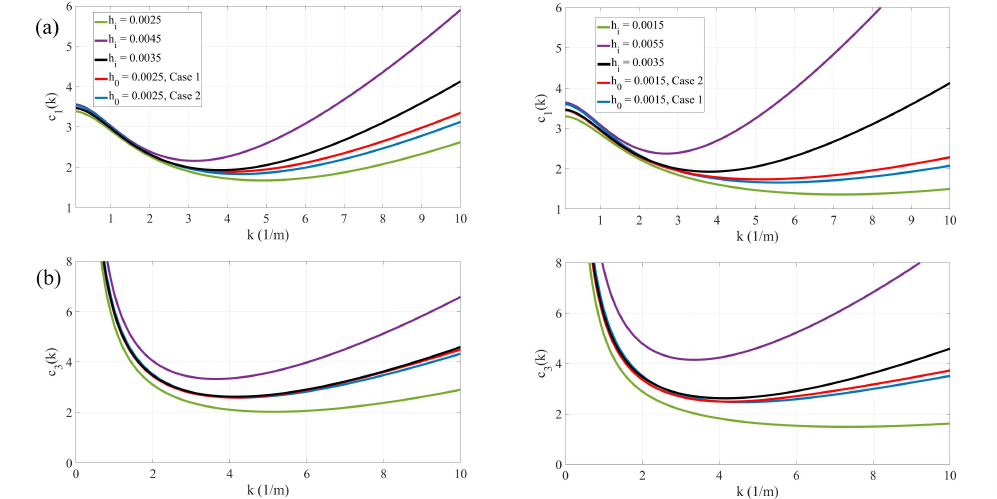
Figure 6. Phase speeds of the first ( a ) and third ( b ) modes for h 0 = 0.0025 m ( left ) and for h 0 = 0.0015 m ( right ) for non-uniform plate and for uniform plate with h i equal to values of h 0 , h ∗ and h 1 of the ice thickness of the non-uniform plate. Colors of lines correspond to the same in Figure